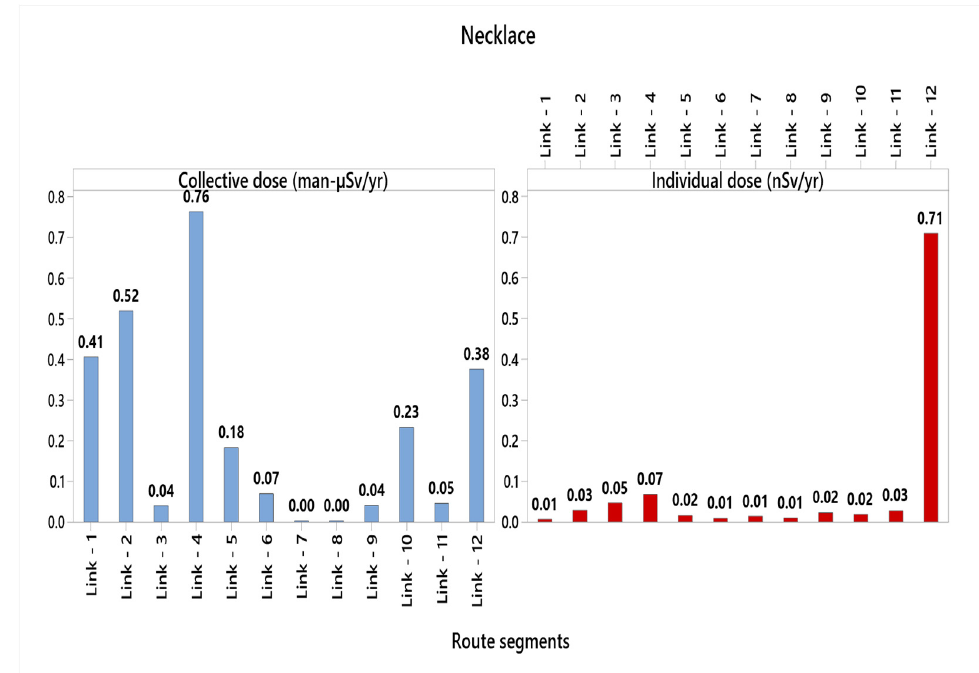
Figure 6. Accident transport result of a necklace (consumer product).